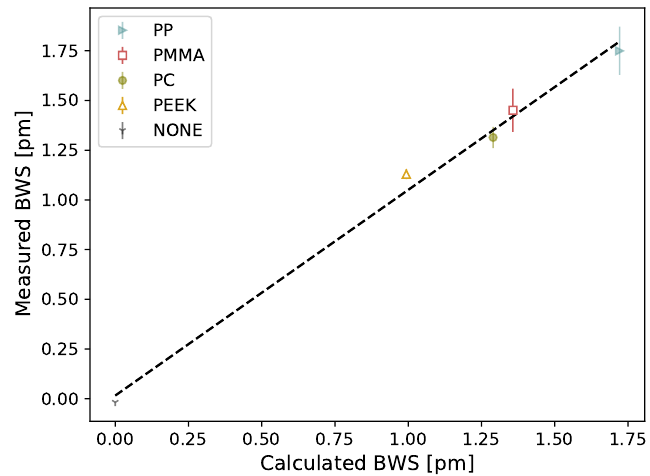
Figure 9. Measured BWS in terms of calculated BWS for different plastics coating with a size of 3 × 3 × 20 mm 3 and a constant 20 Gy irradiation ( y = 1.03 x + 0.02, R 2 = 0.99). The presented values correspond to the means of four measurements and the error bar corresponds to the standard devia- tion. Please note that there is no error bar for the non-coated fiber data point since the measurement was achieved once due to the experimental complexity it represents.